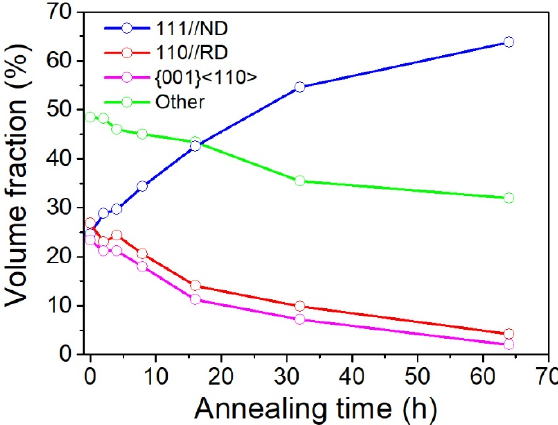
Figure 4. Changes in the volume fraction of Rex grains in the cold-rolled IF steel during annealing at 600 °C for varying time periods. The Rex grain is presented separately for grains of 〈 111 〉 //ND, at 600 ◦ C for varying time periods. The Rex grain is presented separately for grains of (cid:104) 111 (cid:105) //ND, 〈 110 〉 //RD, {001} 〈 110 〉 and other texture components. (cid:104) 110 (cid:105) //RD, {001} (cid:104) 110 (cid:105) and other texture